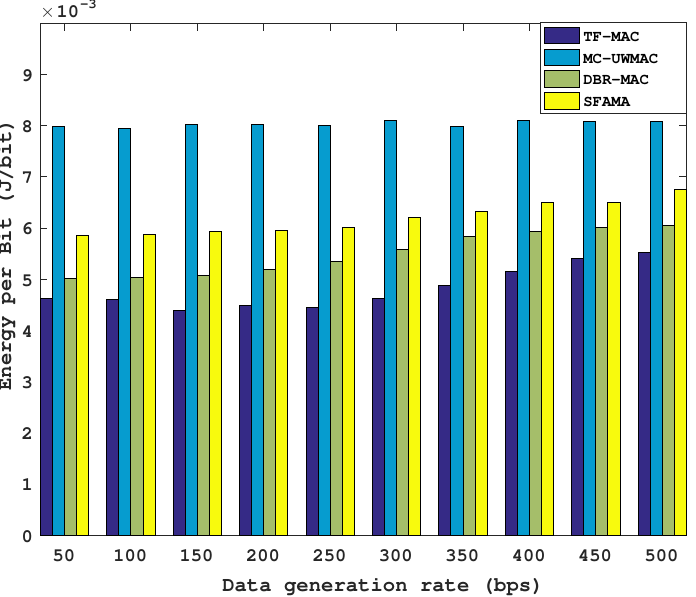
Figure 18. Comparison of energy consumption per bit in the dense